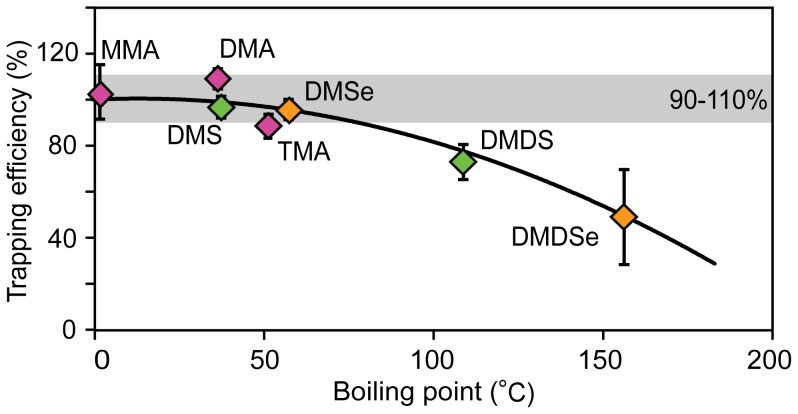
Relationship between the efficiency of chemotrapping in nitric acid and boiling points of the studied volatile compounds.Error bars indicate the standard deviation of the measurements of triplicate samples.